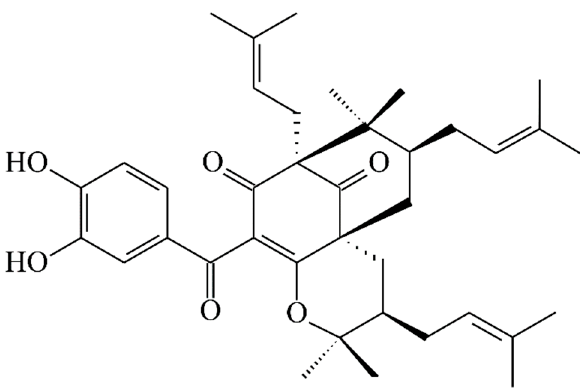
Figure 2. The chemical structure of garcicowin C. Figure 5. The chemical structure of isoxanthochymol.